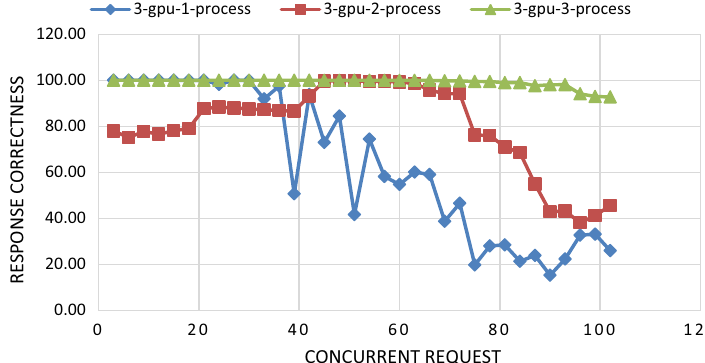
Fig. 6 Success rate % based on the concurrent request for 3